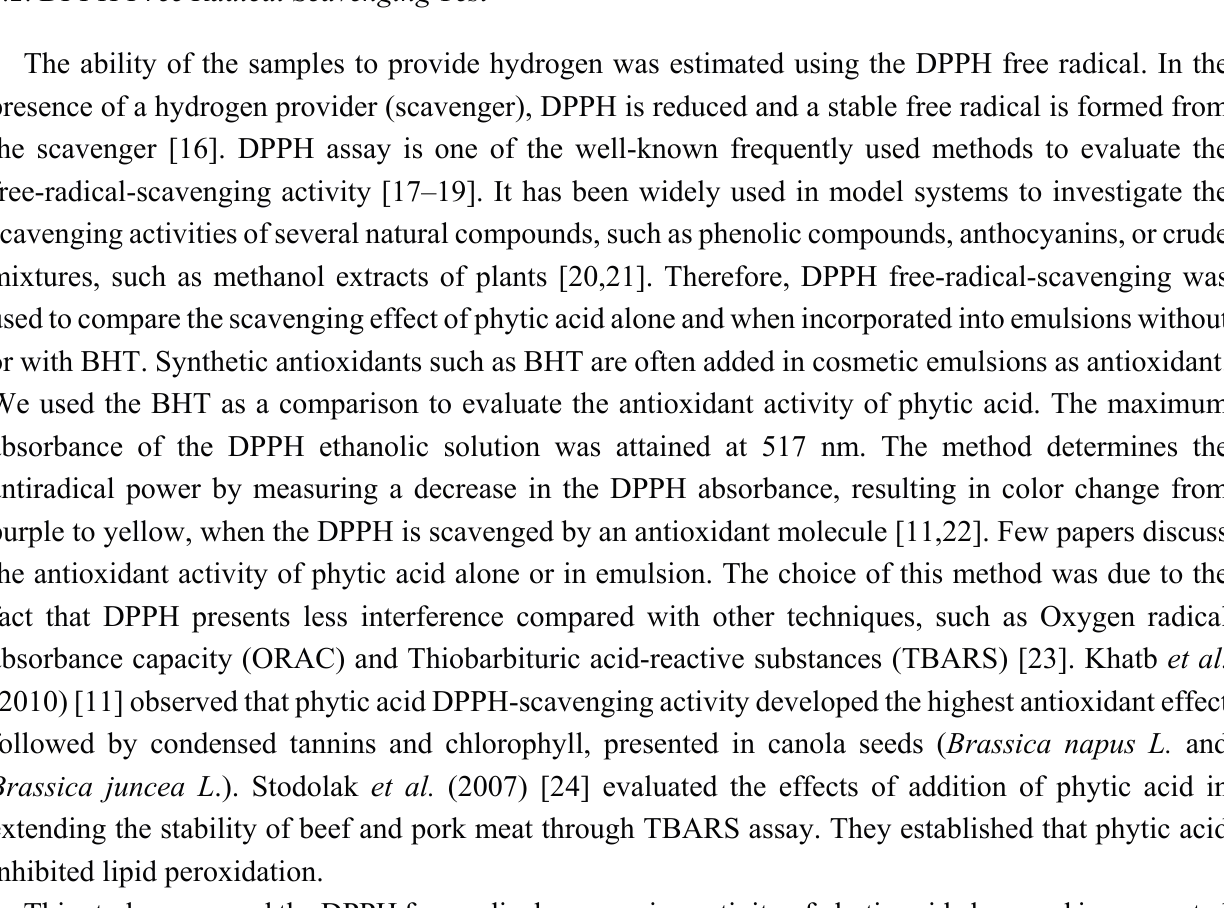
Figure 3. TG/DTG curves of the: emulsion; phytic acid (5.0% w / w ); lanolin ethoxylated; Cetearyl alcohol-ceteth10; propyleneglycol; cyclopentasiloxane; emulsion phytic acid 5.0% ( w / w